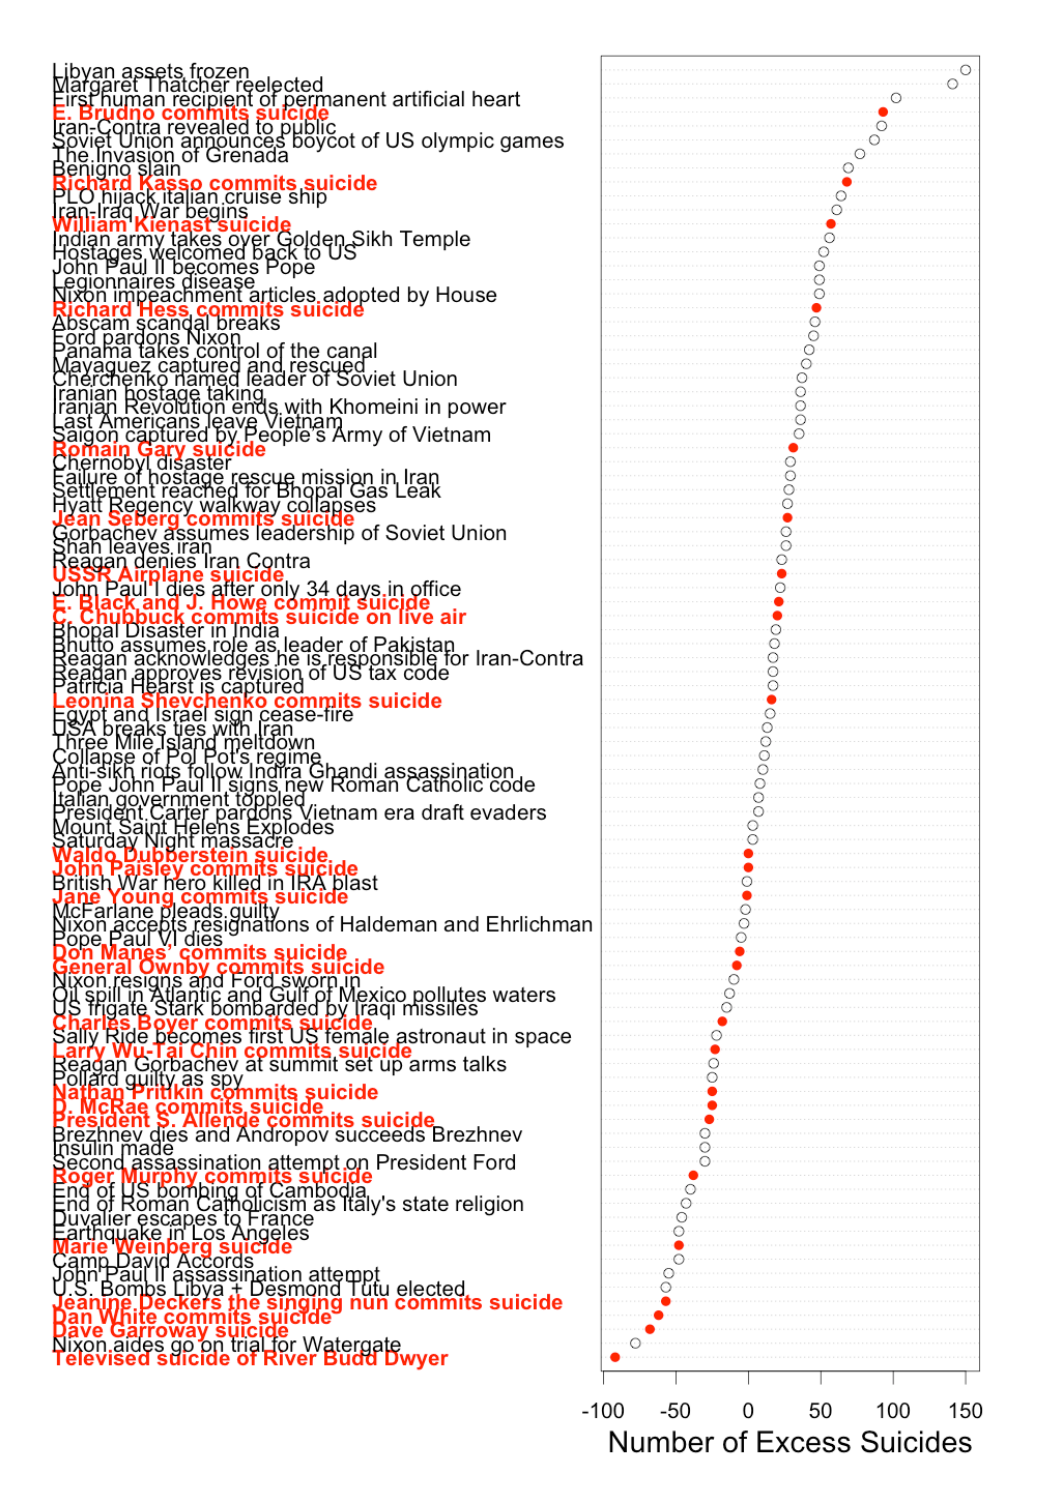
Figure 1: Excess suicides arising from exceptional events and celebrity suicides,